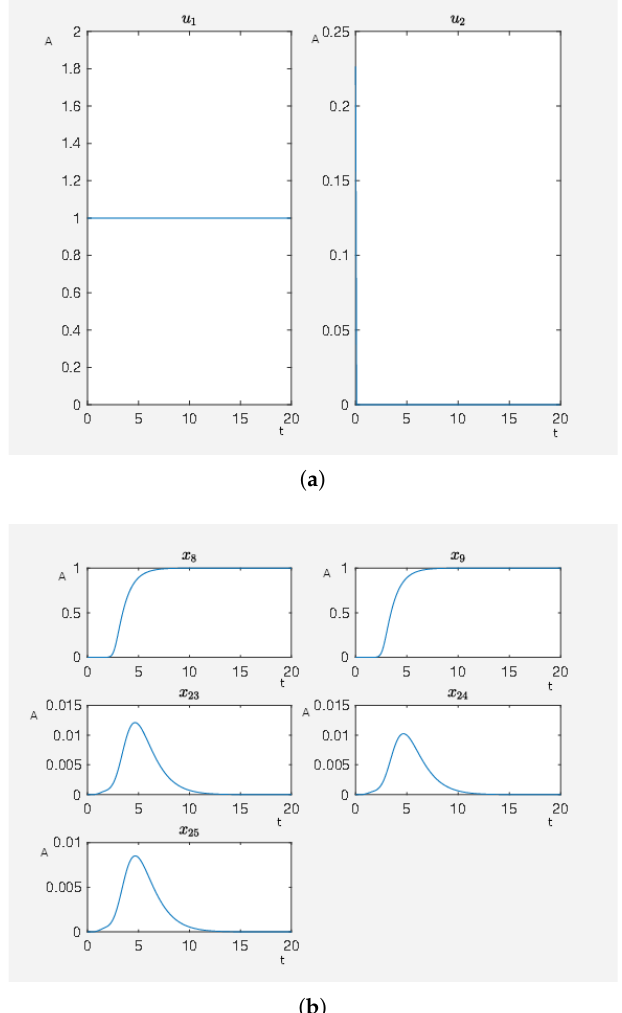
Figure 3. A non-hypertrophic stimulus with carbachol and angiotensin II. ( a ) Time curve of the external stimuli where u 1 activates carbachol and u 2 angiotensin II. On the abscissa, we have the time (t) and on the ordinate the activity level (A). ( b ) Time curve of the nodes of interests where x 8 is the activity level of p90RSK, x 9 is the activity level of p70S6K, x 23 is the activity level of Elk1, x 24 is the activity level of MSK1 and x 25 is the activity level of c-Myc. On the abscissa, we have the time (t) and on the ordinate the activity level